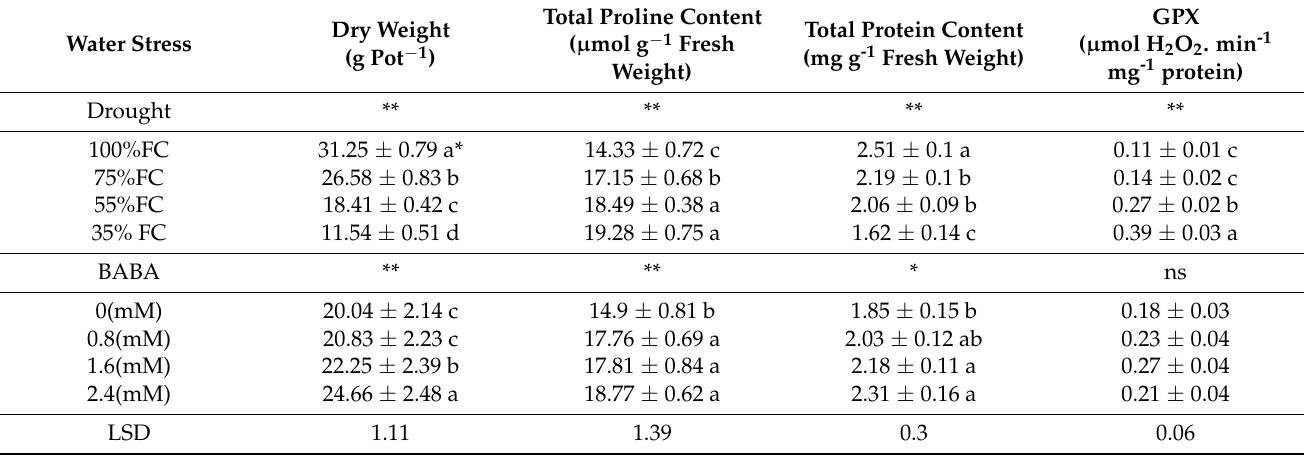
Table 2. Simple effects of foliar application of BABA and water stress on dry weight, proline, protein, and GPX